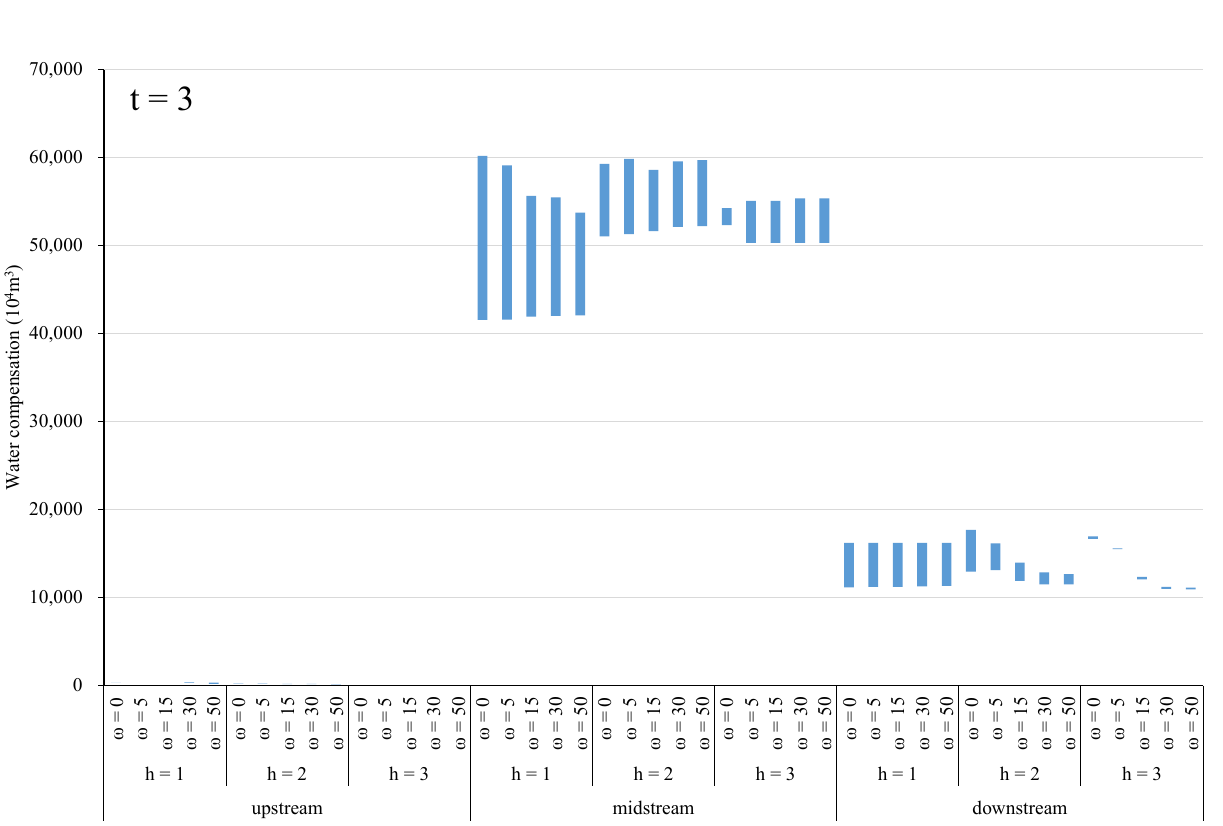
Figure 6. Water compensation by region in the Fenhe River Basin in period 2.